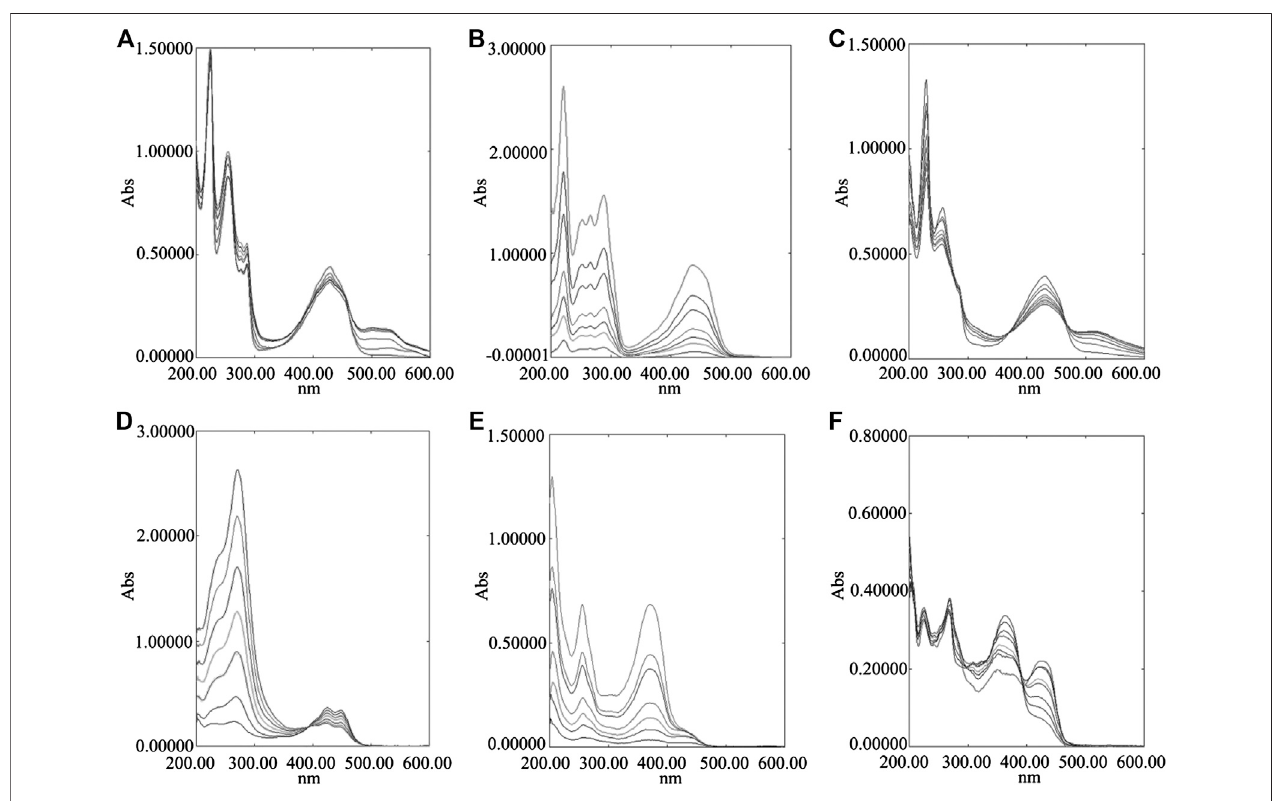
FIGURE 5 | UV-Visible absorption spectra of six compounds coordinated with different concentrations of Cu 2+ . (A) chrysophanol; (B) emodin; (C) rhein; (D) curcumin; (E) quercetin; (F) kaempferide.